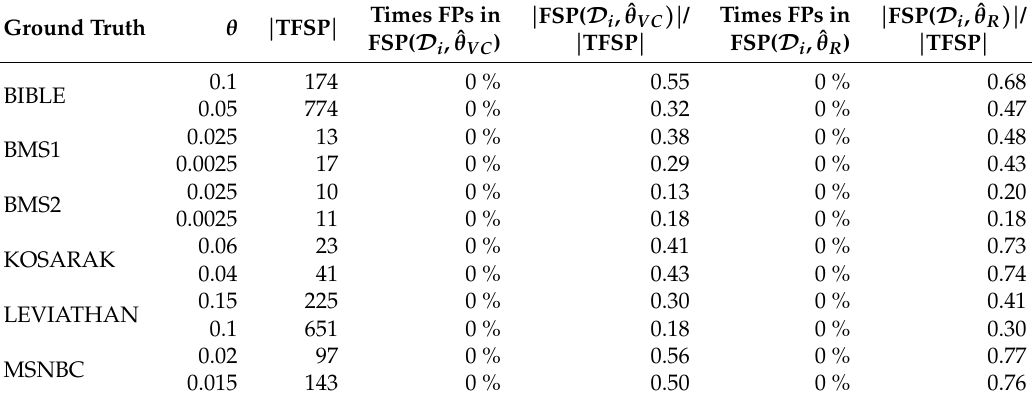
Table 5. Results of our algorithm for the TFSPs with guarantees on the false positives in 4 pseudo-artificial datasets D i for each ground truth. The table reports the frequency thresholds θ used in the experiments, the number of TFSPs in the ground truth, the number of times the output contains false positives using ˆ θ VC = θ + µ VC /2 as frequency threshold and the average fraction of the reported TFSPs in the output using such frequency threshold, the number of times the output contains /2 and the average fraction of the reported TFSPs in the output using false positives using ˆ θ R = θ + µ a R such frequency threshold.